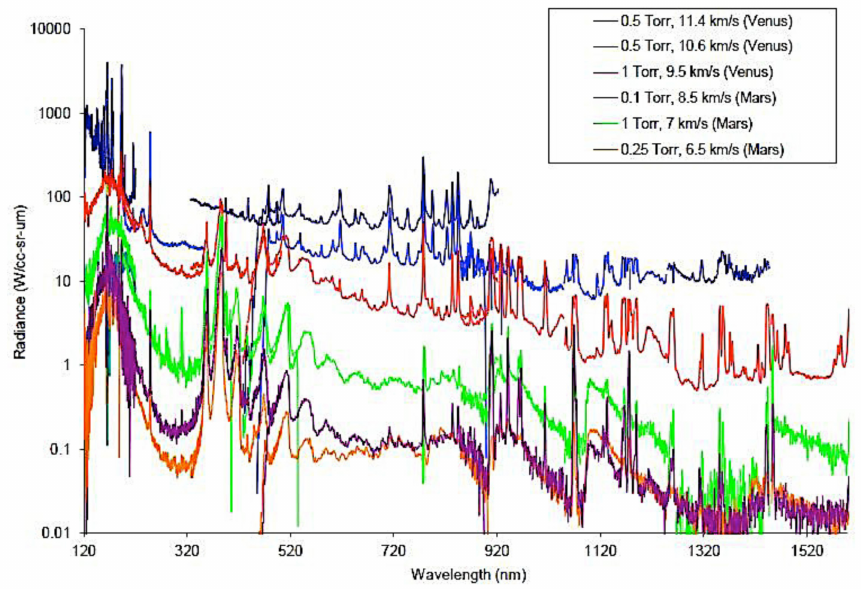
Figure 9. Mars and Venus spectra obtained in [1].